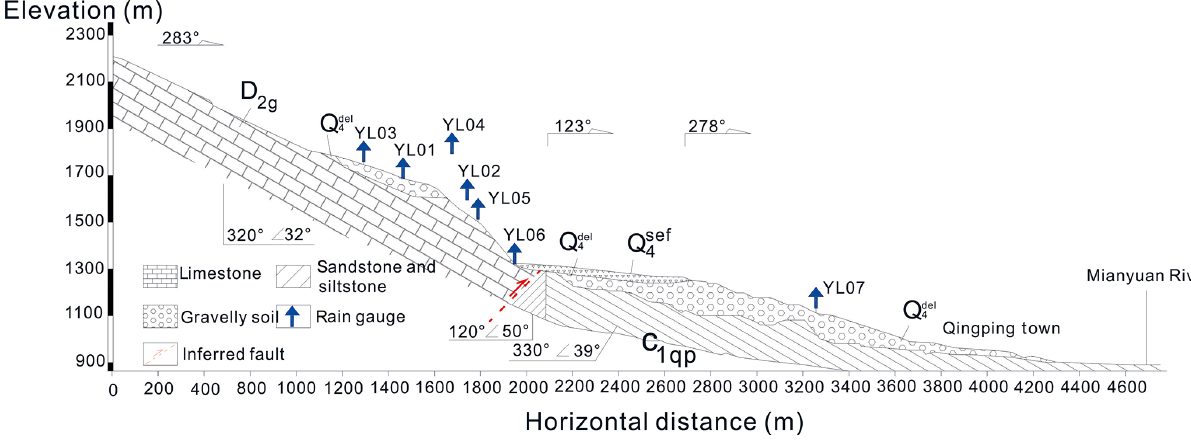
Figure 4. Geological profile of the main channel of Wenjia